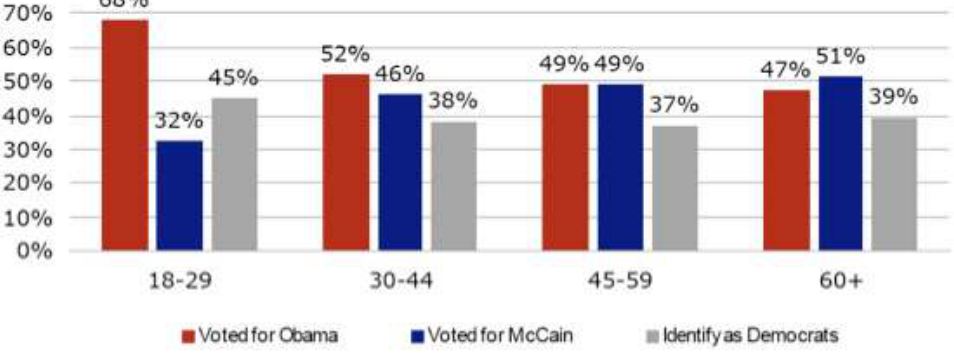
Figure 3: Voter preferences in US 2008 election by age class (Marcelo et al. 2008) Back in 2007, the New Politics Institute, a US based think tank, published a speech by Chris Kelly, Chief Privacy Officer and Head of Global Public Policy at Facebook. According to him, the rise of “computer” networks could pragmatically assist politicos and advocacy organizations in